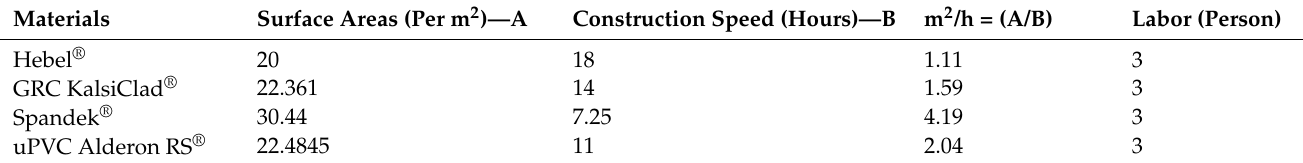
Table 3. The construction speed of cladding wall materials.